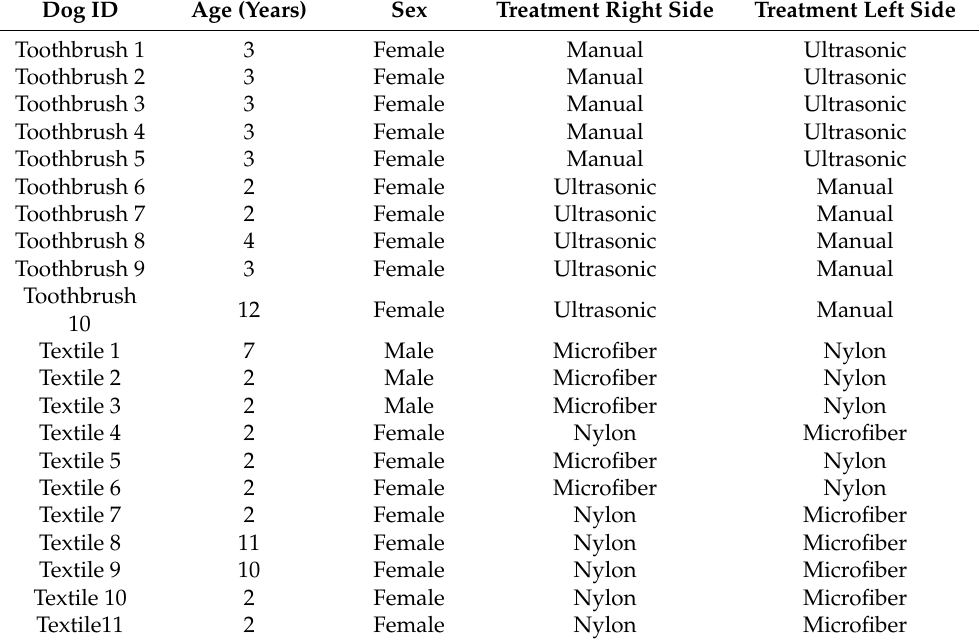
Table 1. Age, sex, and treatment allocation of participating dogs.